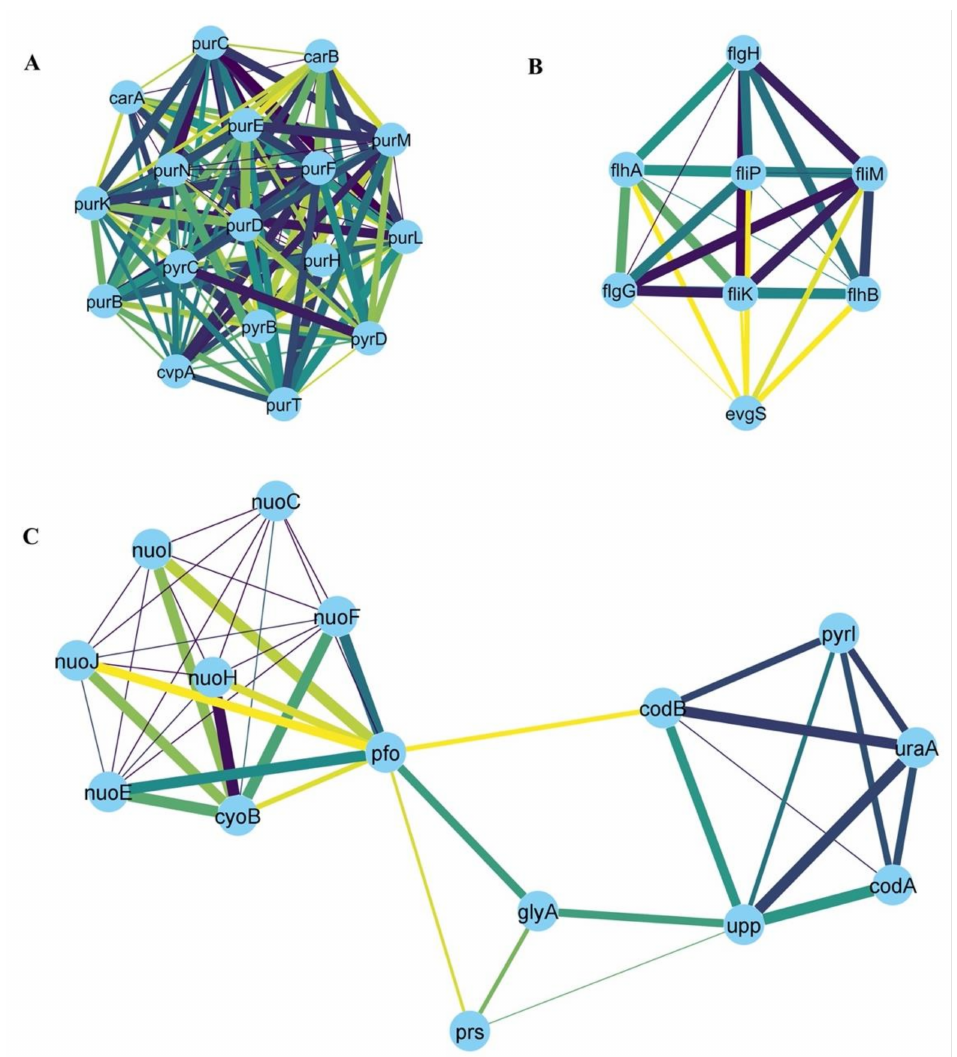
Figure 7. Three main sub-clusters (numbered from A – C ) were identified by the MCODE clustering algorithm from the network of the downregulated genes in at least four stressors. Examples of the hub genes are briefly discussed in the Discussion